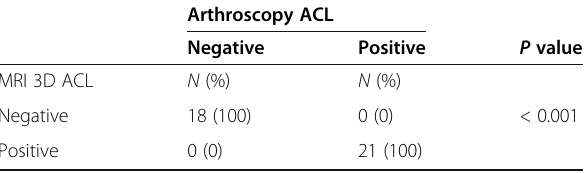
Table 8 Arthroscopic findings correlated with MRI protocol B for ACL